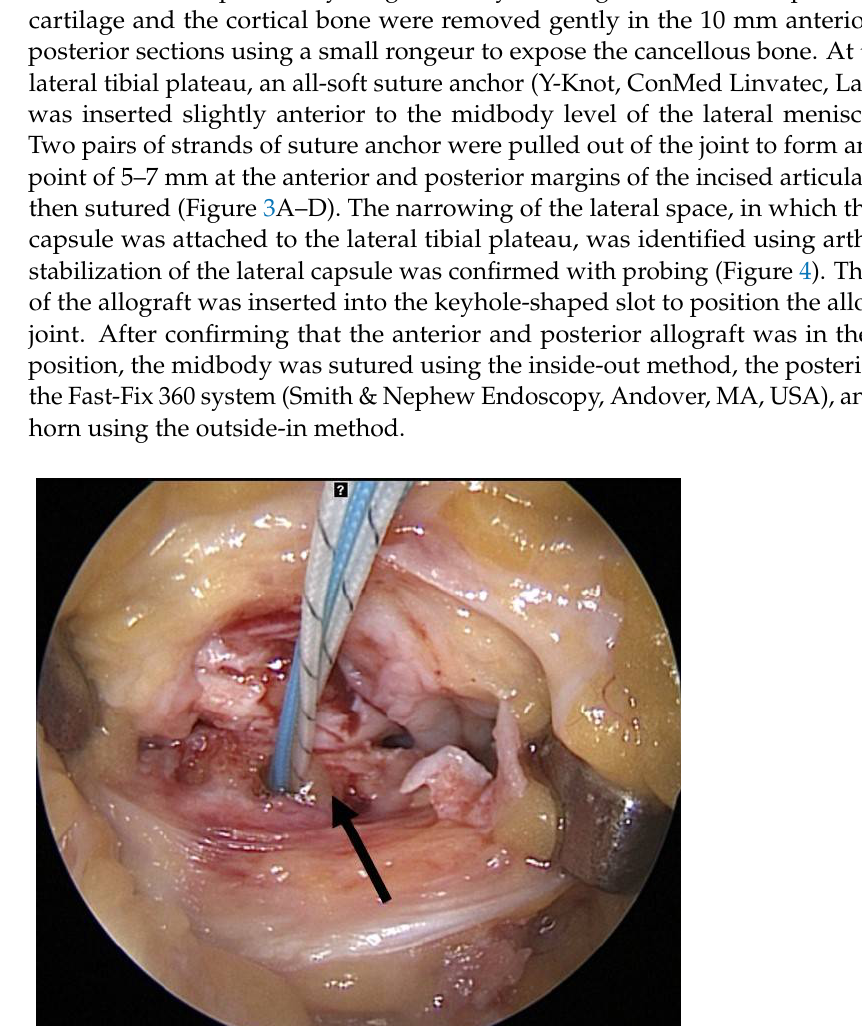
( D ) Figure 3. Capsulodesis using an all-soft suture anchor. ( A , B ) Two pairs of strands of suture anchor are pulled out of the lateral capsule. ( C , D ) They form an X shape and are tied. The lateral capsule is attached to the lateral tibial plateau after capsulodesis.